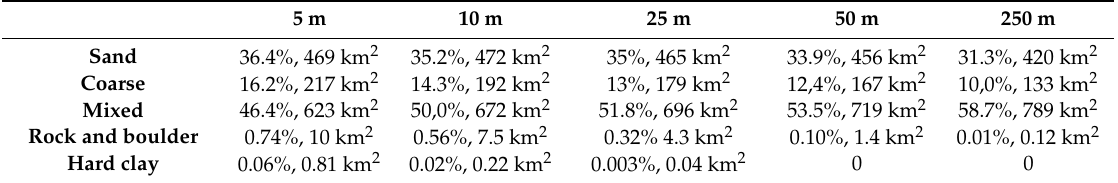
Table 14. Percent coverage changes for HUB level 3 classes as the analysis window changes from 5 m to 250 pixels. Significant changes of cover for the rarer classes occur already at the 10 ‐ m pixels.